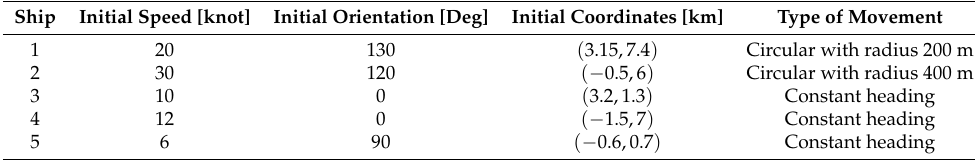
Table 2. Ships initial states and type of movement.